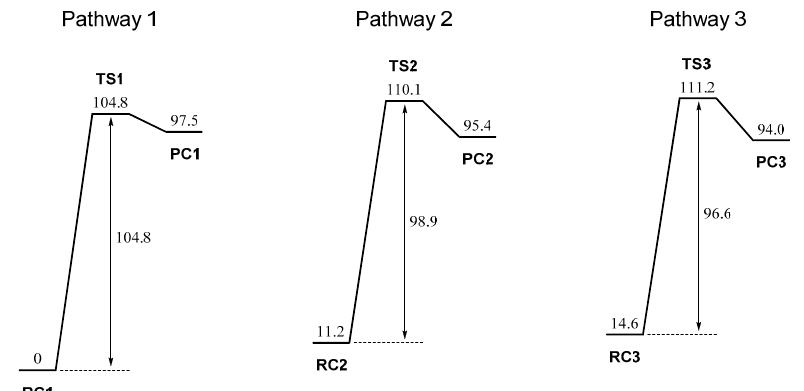
Figure 3. Energy diagrams of the three enolization pathways (pathway 1, pathway 2, and pathway 3)